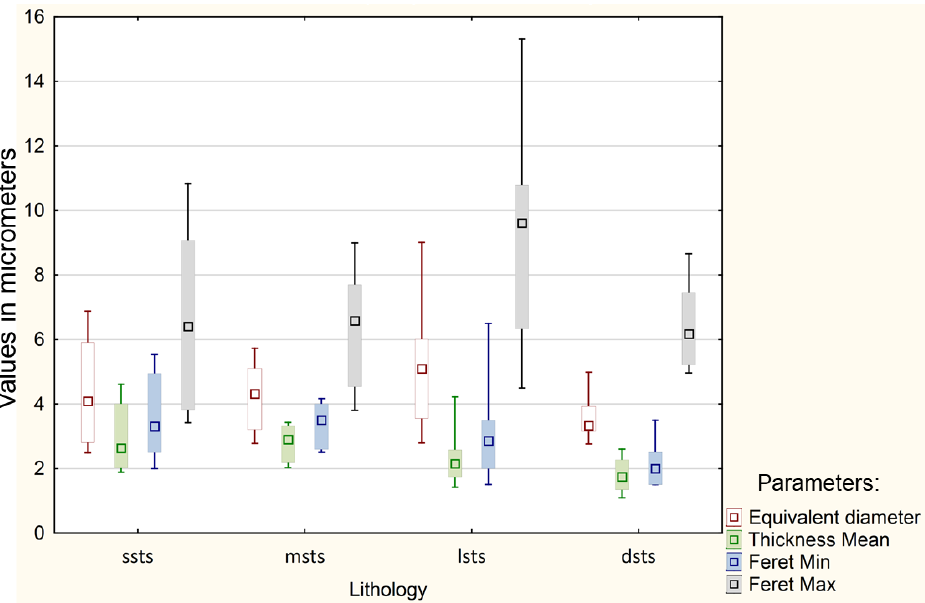
Figure 6. Geometric parameters in the form of diameters (Equivalent dimeter, Thickness mean, Feret minimum diameter— Feret Min, Feret maximum diameter—Feret Max) in 4 lithology groups. Symbols as in Figure 1.